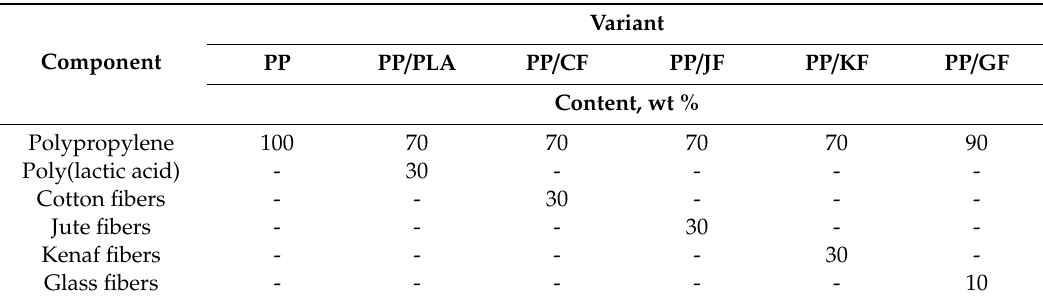
Table 1. Composition variants of analyzed